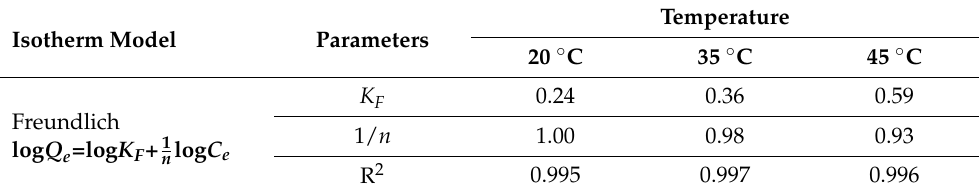
Figure 9. ( a ) Adsorption isotherm of DOXY on SA–DCNC-40 hydrogel beads at varying temperatures, and the data fitted by ( b ) Langmuir and ( c ) Freundlich isotherm models. Table 4. Freundlich adsorption isotherm parameters for DOXY removal by SA–DCNC-40 at different temperatures.